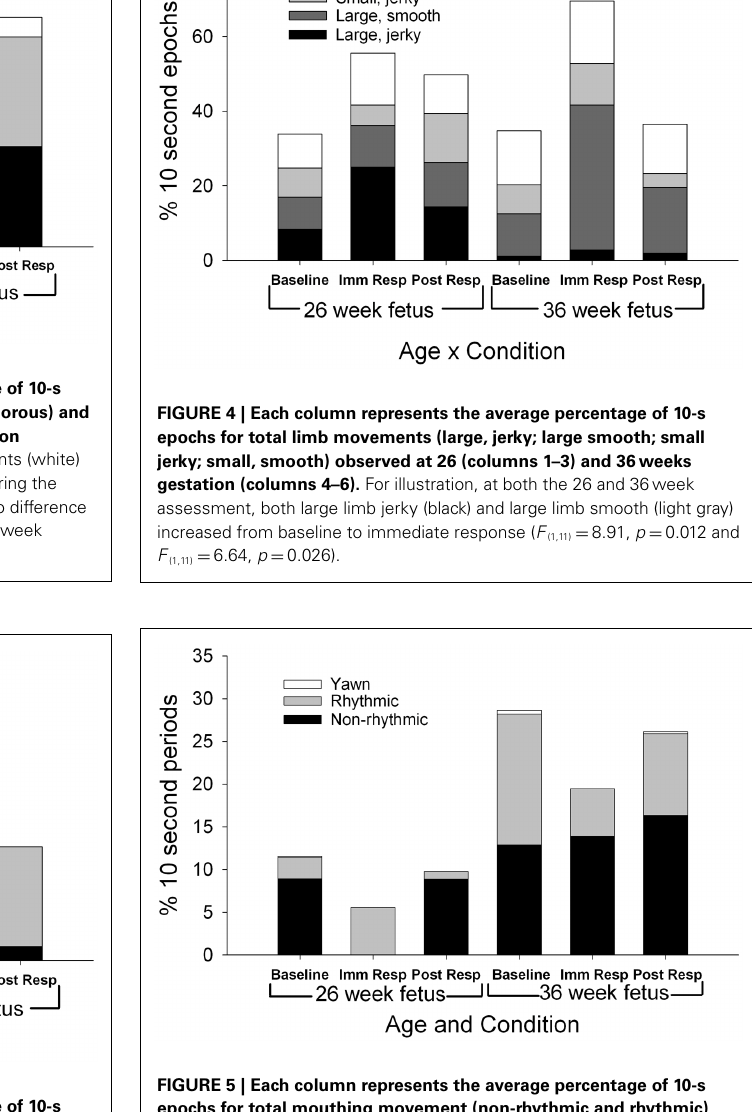
FIGURE 3 | Each column represents the average percentage of 10-s epochs for all general body movements (smooth and jerky), bacharch, startle, and stretch observed at 26 (columns 1–3) and 36weeks gestation (columns 4–6). For illustration, jerky general body movements (light grey) are observed less frequently at the 36week versus 26week assessment ( F (1,11) = 4.85, p = 0.05). period compared to the baseline period [ F (2,22) = 4.76, p = 0.024]. The age by period interaction was also significant for regular fetal breathing [ F (1,11) = 4.46, p = 0.027]. Immediately after the VAS, the fetuses at the 36-week assessment decreased regular fetal breathing movements [ t (11) = 3.36, p = 0.006], however, no sig- response in the fetuses at the 26-week assessment [ t (11) = 0.77, p = 0.46]. Irregular fetal breathing movements demonstrated no significant differences between periods [ F (2,22) = 0.174, p = 0.84]